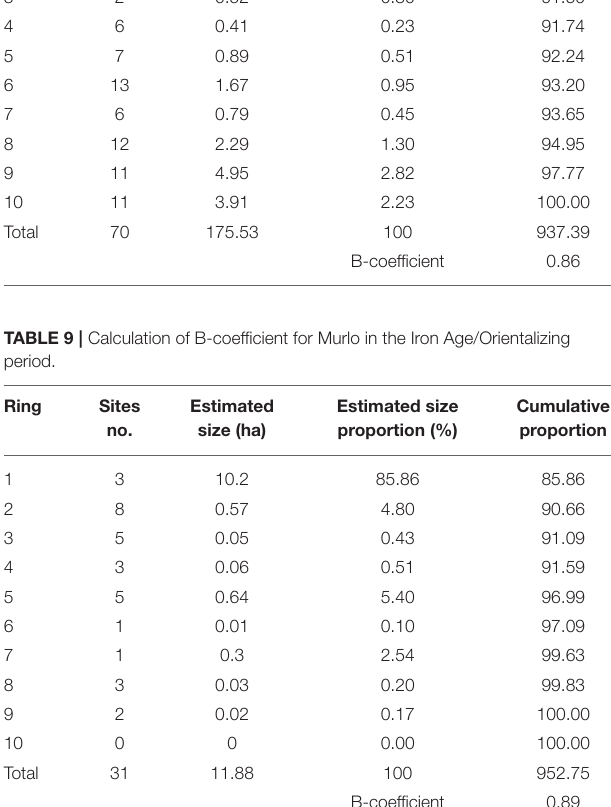
TABLE 6 | Calculation of B-coefficient for Cerveteri in the Iron Age/Orientalizing period. Ring Sites no.